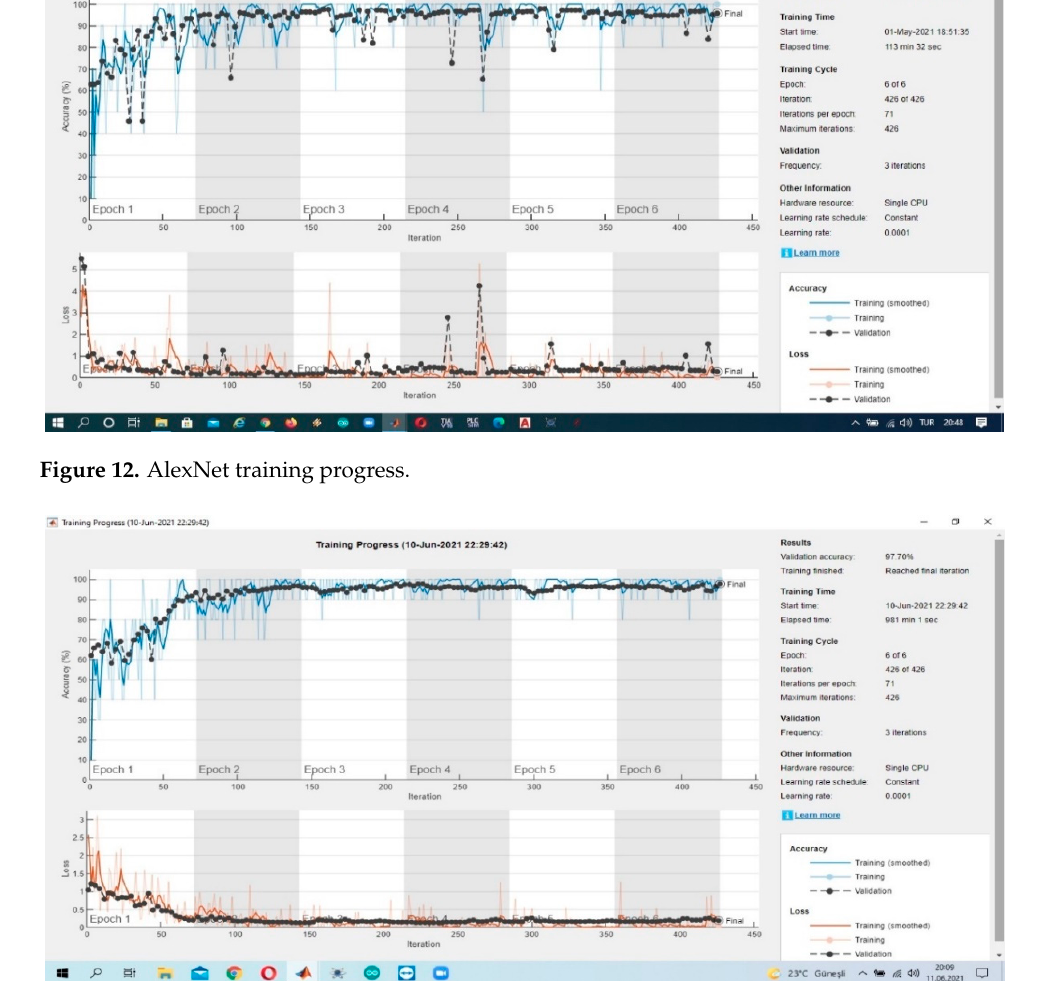
Figure 12. AlexNet training progress.